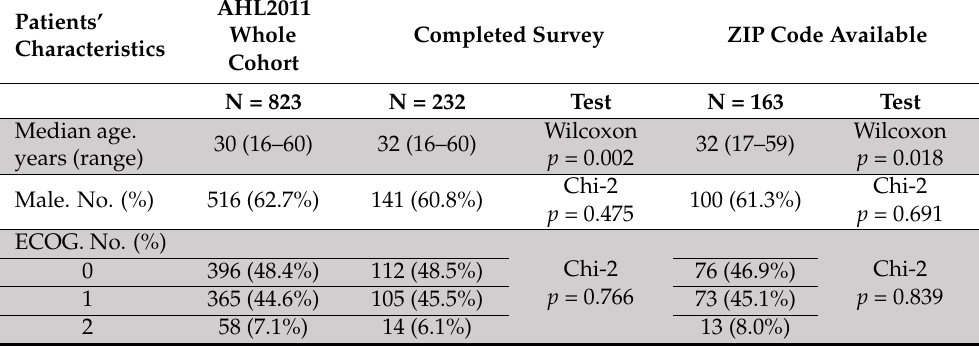
Figure 1. Flowchart displaying the number of patients who completed the survey and those with the ZIP codes reported (geographical data available) in the AHL2011 trial. Table 1. Key baseline patient characteristics with the respective subsets according to the availability of the